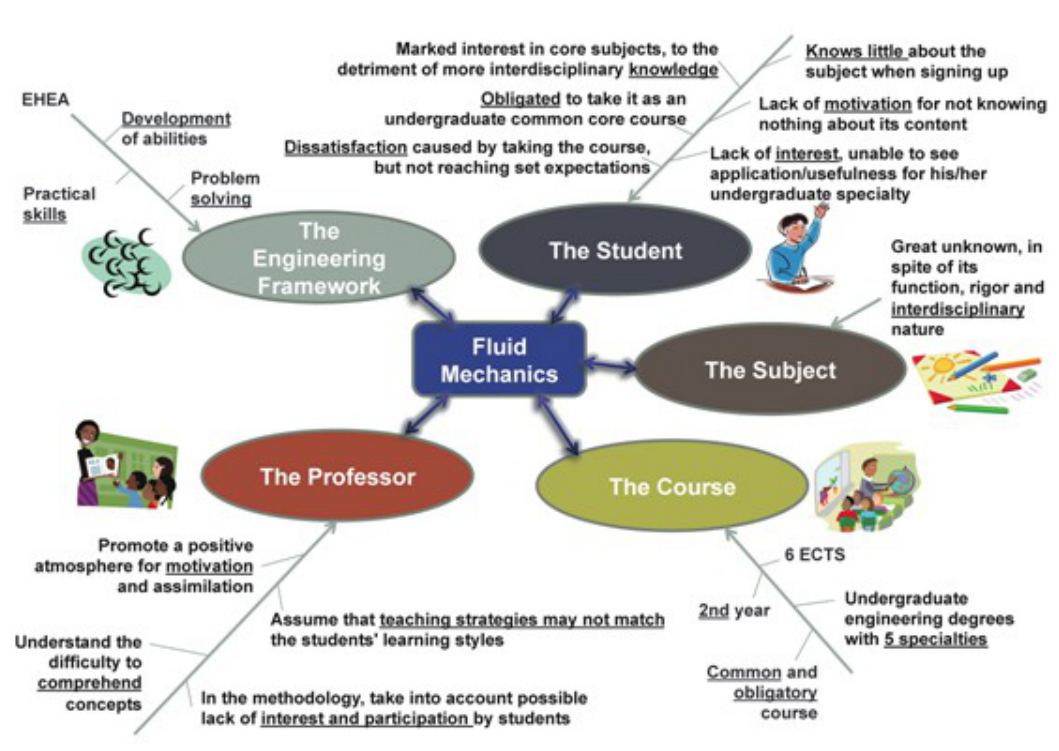
Figure 1. Mental map of the environment and context surrounding the Fluid Mechanics